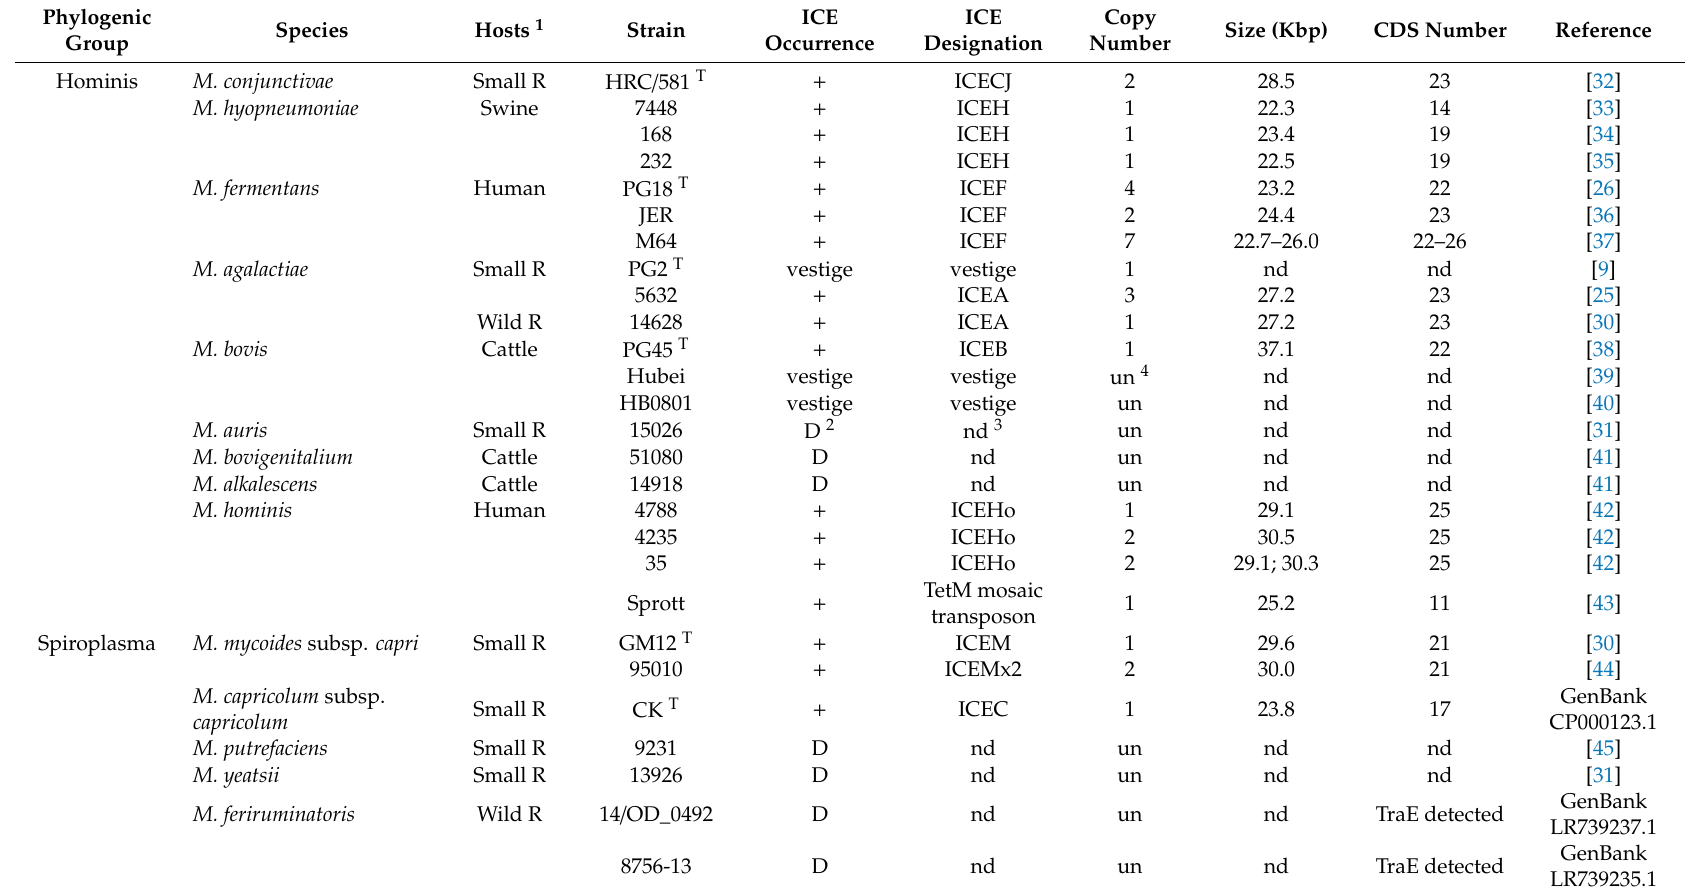
Table 1. Mycoplasma integrative conjugative elements